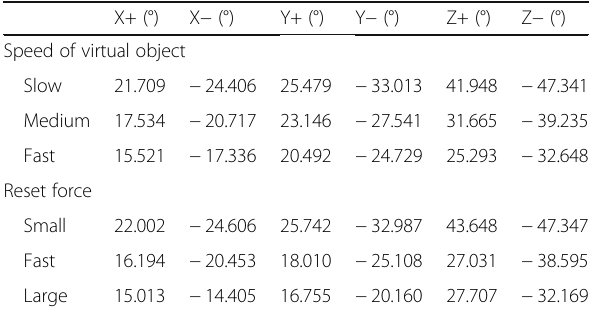
Table 7 Operating range statistics